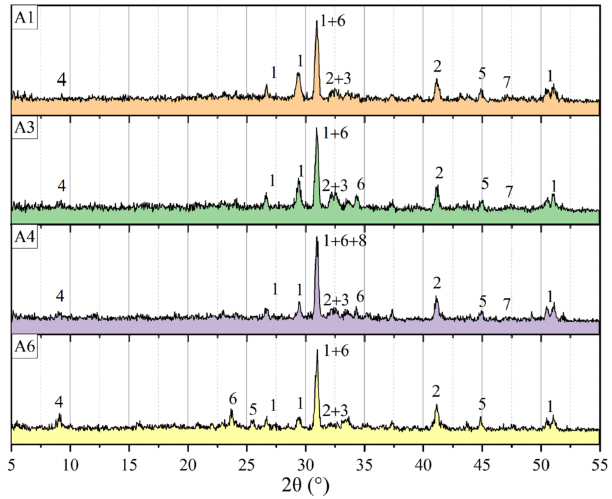
Figure 11. XRD patterns of UHPC based on composite cementitious material: 1- C - S - H , 2- C 2 S , 3- C 3 S ,